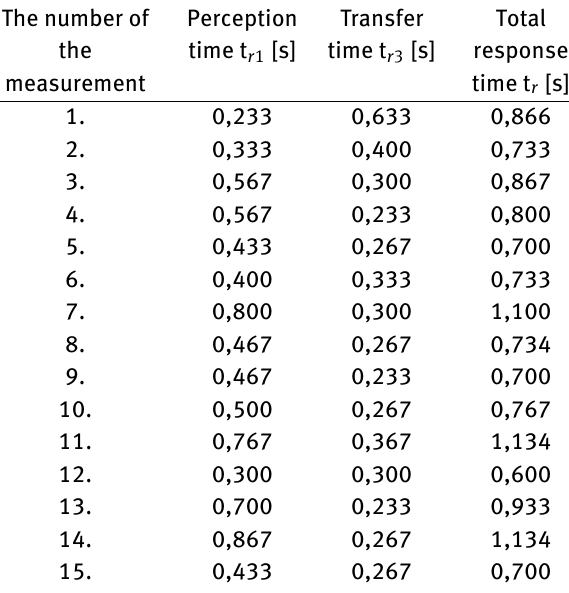
Table 12: Summary of the results of driver